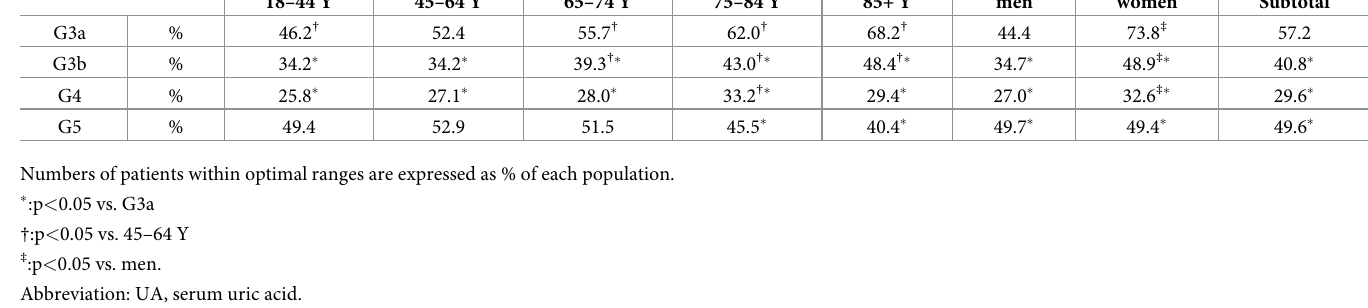
The adjusted odds ratios and 95% confidence intervals for electrolyte disorders according to G category strata are shown in Table 6. Logistic regression analysis demonstrated that the respective prevalences of hyponatremia, hyperkalemia, hypercalcemia, hyperphosphatemia, and narrower serum Na–Cl level were elevated in patients with CKD stages G3b, G4, and G5, compared with those prevalences in patients with CKD stage G3a. The prevalence of hypocal- cemia was elevated only in patients with CKD stage G5. Further logistic regression analysis (model 4) showed that a narrower serum Na–Cl level was associated with the prevalence of hyperkalemia (adjusted odds ratio, 3.18 [95% confidence interval, 2.13–4.74]), independent of G category (S5 Table).